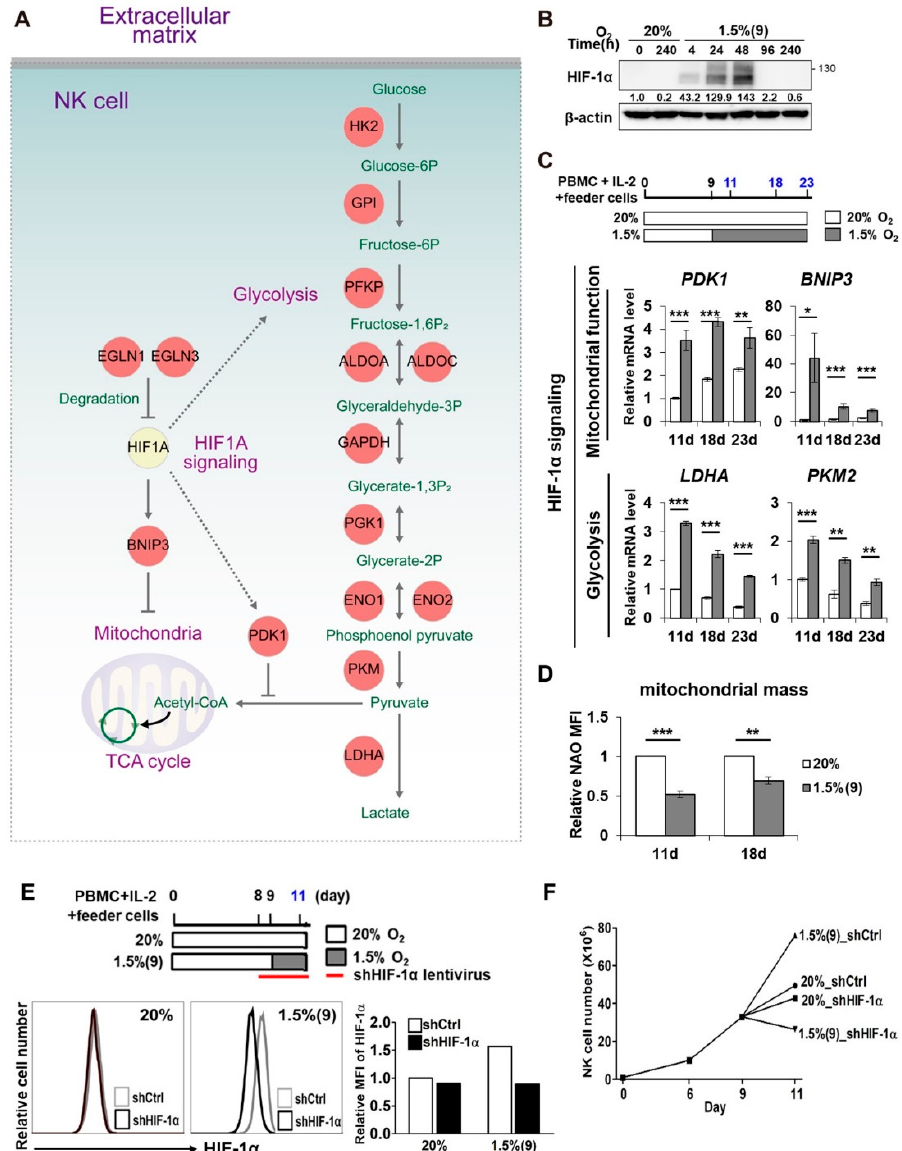
Figure 4. Enhanced proliferation of pre-activated hypoxic NK cells is dependent on HIF-1 α activity. ( A ) Network model includes the upregulated HIF-1 α signaling and glycolysis. The nodes and lines are as described in Figure 3E. ( B ) Western blot analyses were performed to assess time-dependent changes of HIF-1 α expression in normoxic and hypoxic cultured NK cells. β -actin was taken as a loading control. ( C ) qRT-PCR analyses of PDK1, BNIP3, LDHA, and PKM2 in NK cells at days 11, 18, and 23 are shown. NK cells in PBMCs were expanded with IL-2 and feeder cells under normoxic or hypoxic conditions and then isolated on the indicated days. Their expression levels were normalized using that of 18S rRNA and further divided by normalized level of the gene in normoxic NK cells at day 11. Data obtained from more than two independent experiments, each using PBMCs from different individual donors, are presented as the mean ± SEM. *, p < 0.05; **, p < 0.01; ***, p < 0.001. ( D ) Mitochondrial mass in NK cells at days 11 and 18 was assessed by NAO staining and analyzed by flow cytometry. Relative levels of mean fluorescence intensity (MFI) from five independent experiments are plotted as bar graphs. Data are presented as the mean ± SEM. **, p < 0.01; ***, p < 0.001. ( E ) Upper , schematic representation of HIF-1 α knockdown. NK cells were infected with lentivirus containing shCtrl and shHIF-1 α at day 8 and exposed to pO 2 of 1.5% after 9-day expansion in normoxia. Lower , HIF-1 α knockdown was verified using intracellular HIF-1 α flow cytometry (left) and HIF-1 α mean fluorescence intensity (MFI) (right). ( F ) Time course of ex-vivo expansion of shCtrl or shHIF-1 α NK cells .